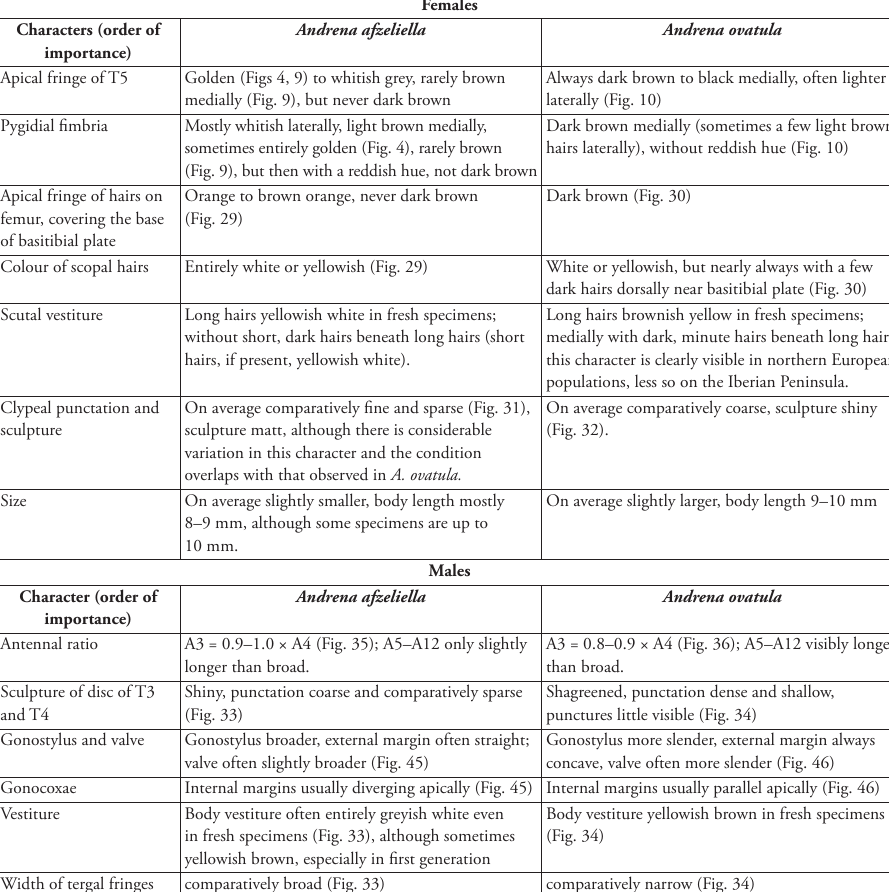
Table 1. Comparison of Andrena afzeliella stat. rev. and A. ovatula (modified from van der Smissen 2010).